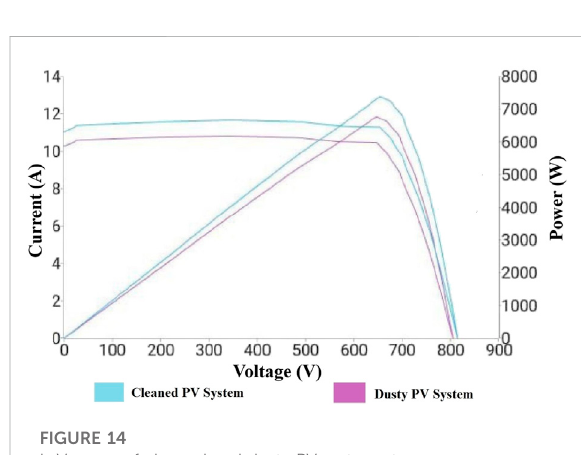
FIGURE 14 I – V curve of cleaned and dusty PV systems to compare system performance in January.